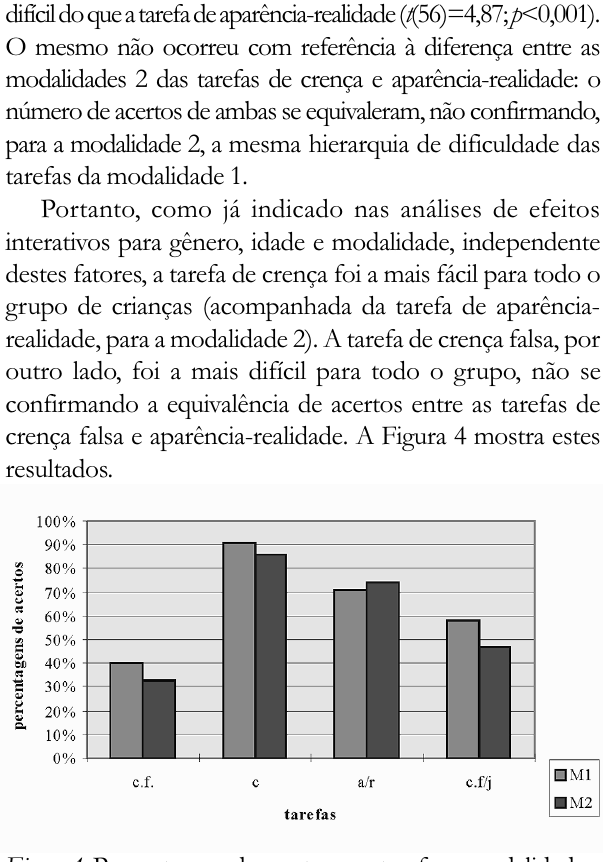
Psicologia: Reflexªo e Cr(cid:237)tica, 2004,